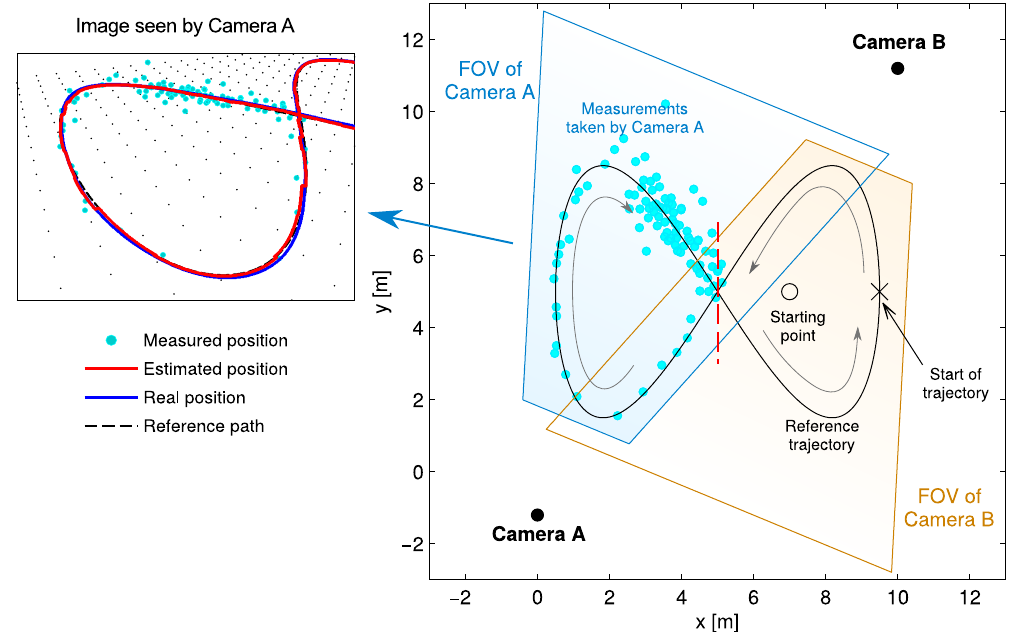
Figure 5. Diagram showing the reference trajectory and the camera locations. Each camera’s field of view (FOV) is